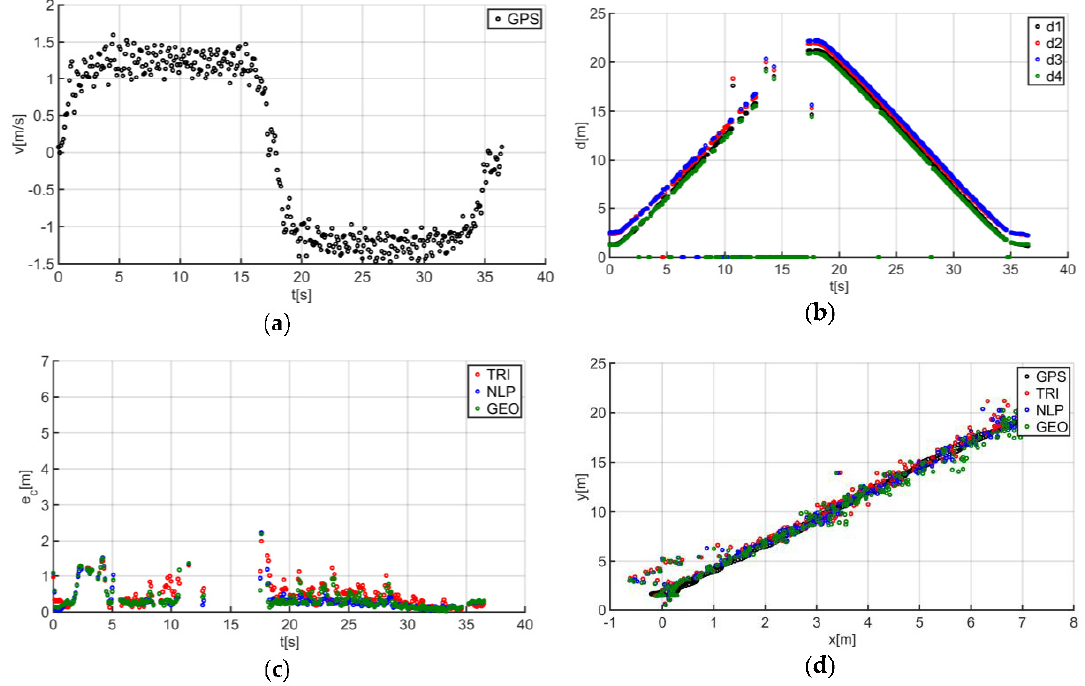
Figure 18. Test results no. 5: ( a ) human guide speed v p (t) and ( b ) filtered distance from anchors d i (t), i = 1, 2, 3, 4; ( c ) course of total location errors e c (t) and ( d ) location of the human guide y p (t) = f(x p (t)).